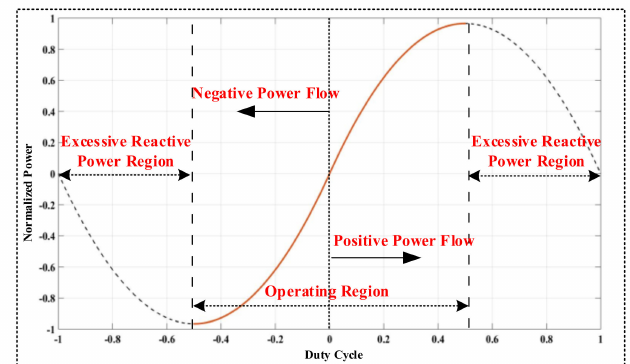
Figure 4. Power transfer characteristics of a DAB according to the duty cycle.